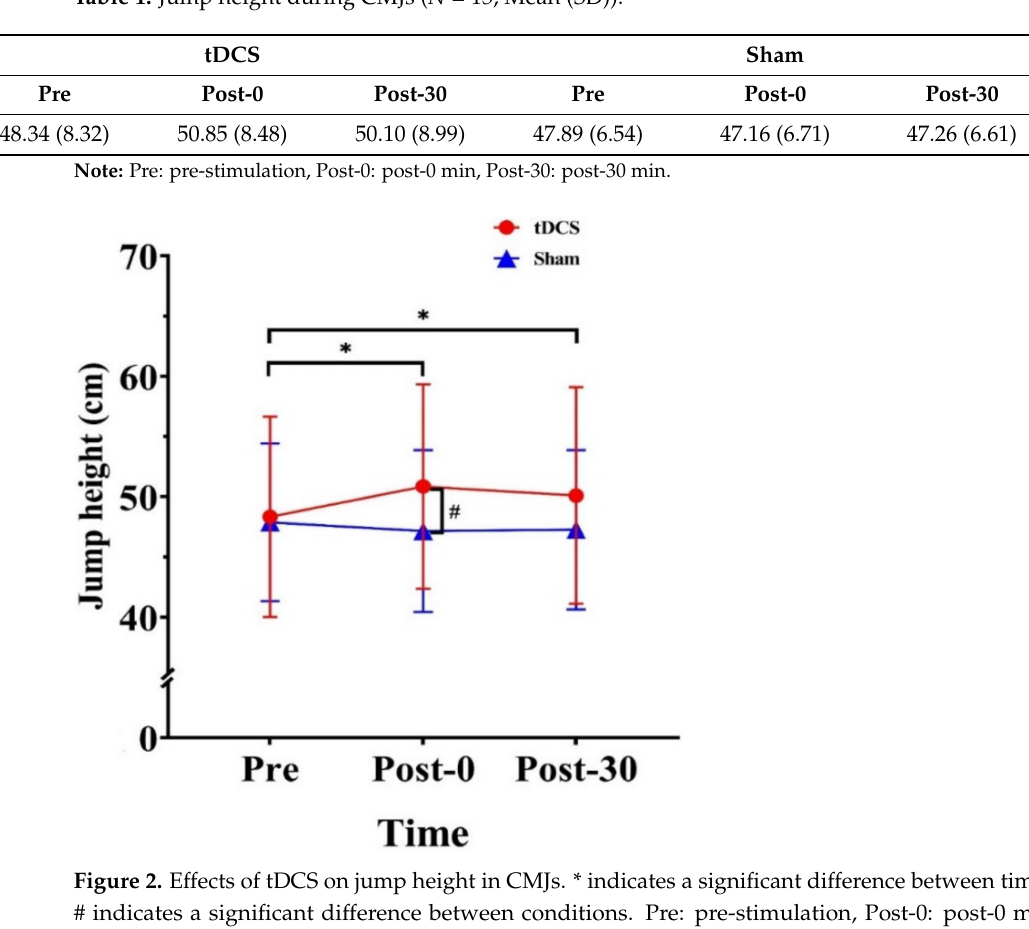
Table 1. Jump height during CMJs ( N = 15, Mean (SD)).